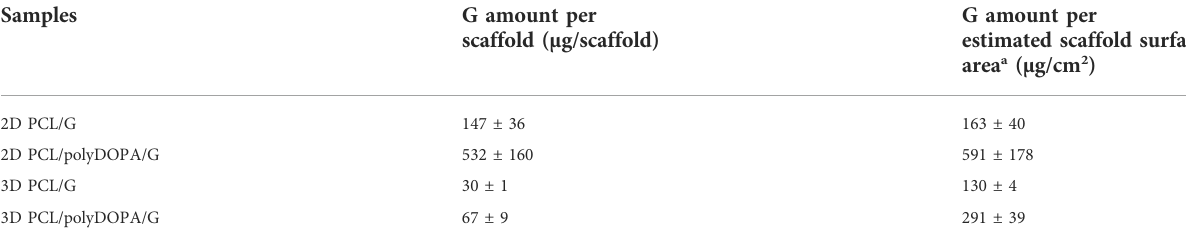
TABLE 2 Gelatin quanti fi cation through BCA colorimetric assay for 2D and 3D PCL/PolyDOPA/G scaffolds compared to PCL/G scaffolds.